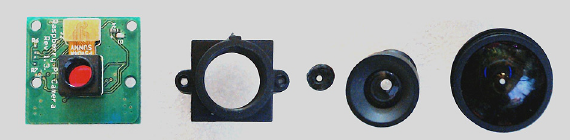
Figure 2: Lens modification accessories